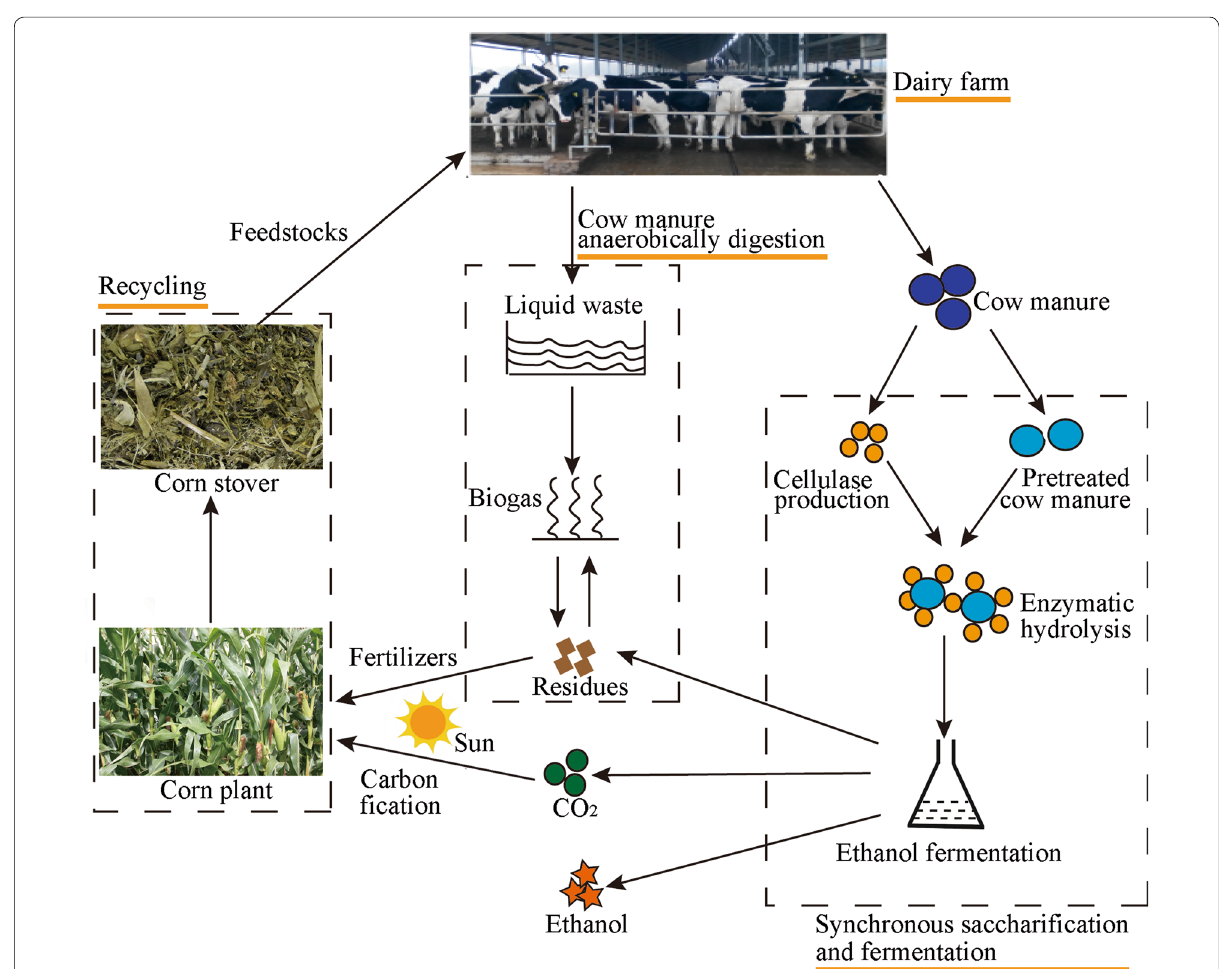
Fig. 5 Integrated biorefinery approach using cow manure for cellulolytic enzyme, bioethanol and biogas